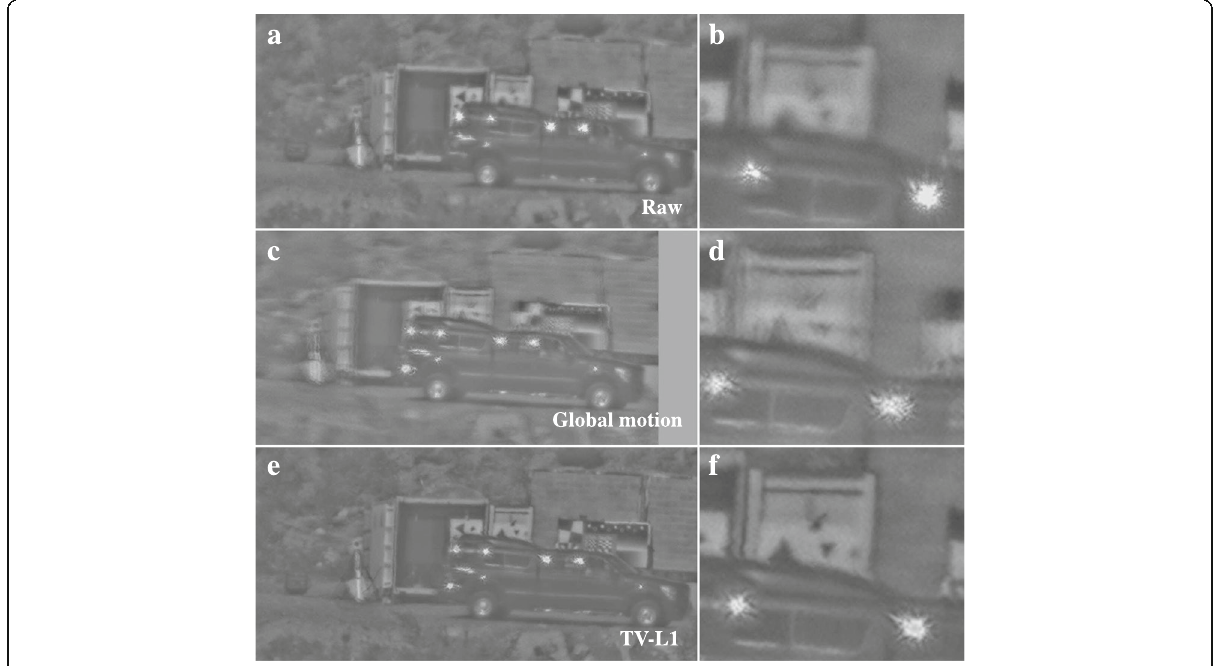
Fig. 5 Turbulence mitigation on a moving truck in front of a set of test charts. The top row shows a still from the raw video ( a ) and a cut-out around the top of the truck ( b ). The middle row shows ( c - d ) the processing results with the global turbulence mitigation method and the bottom row ( e - f ) shows the result for dynamic turbulence mitigation with TV-L1 optical flow. The truck is about 530 × 210 pixels in